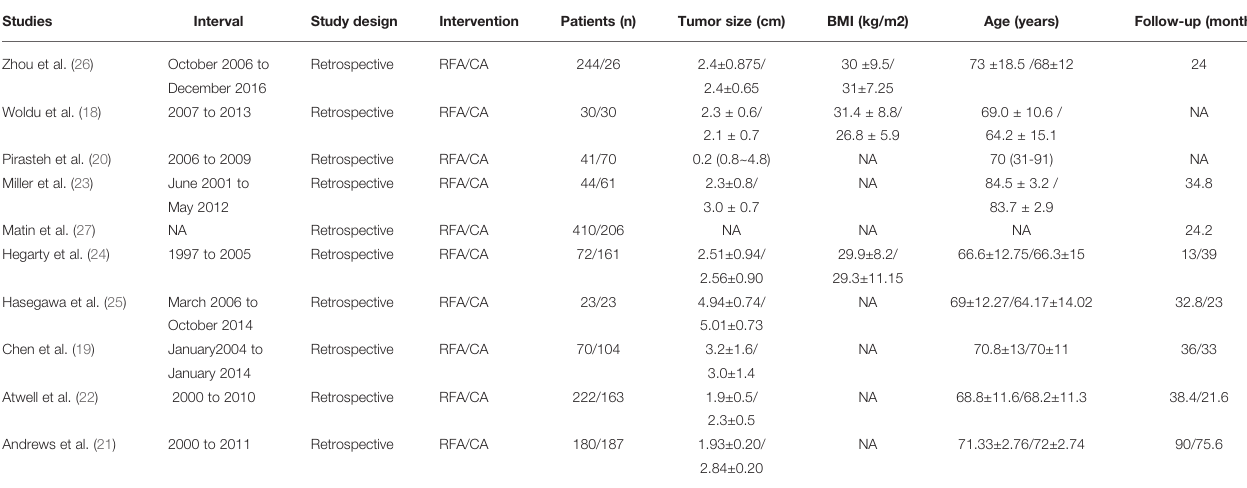
TABLE 1 | Baseline characteristics of include studies and methodological